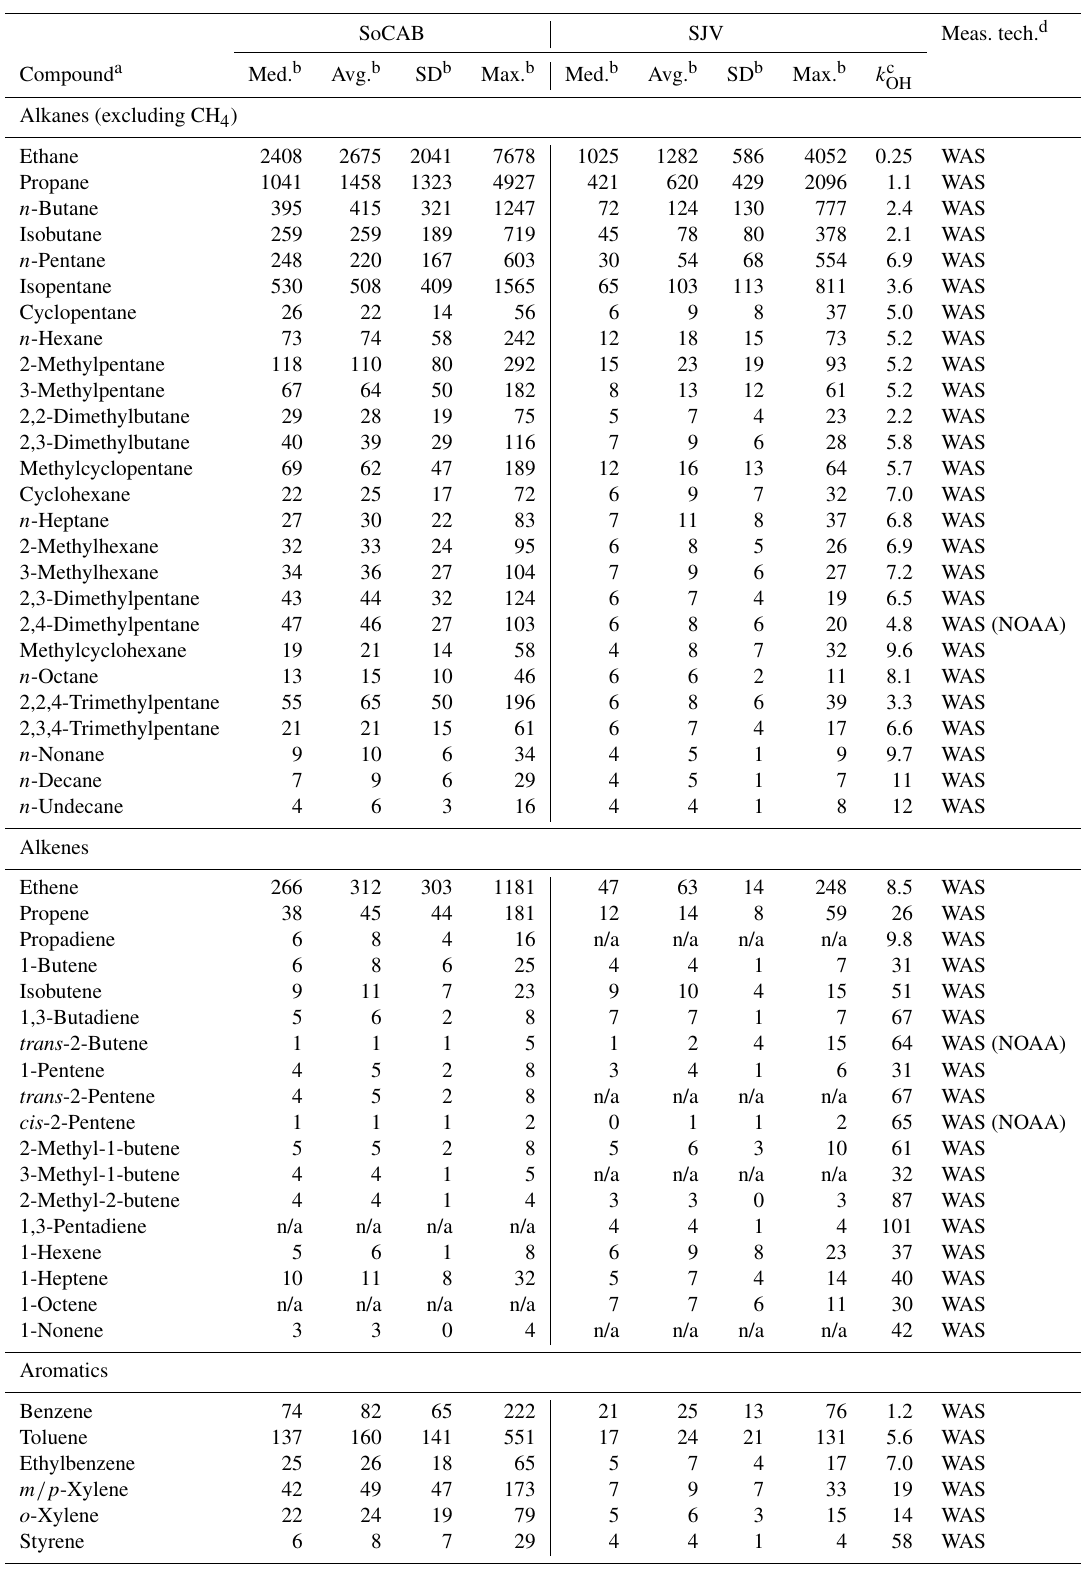
Table 2. Statistics of the mixing ratios (median, average, 1 σ standard deviation, and maximum values in parts per trillion (ppt), unless otherwise specified) and OH reaction rate coefficients of the measured VOCs in the SoCAB and